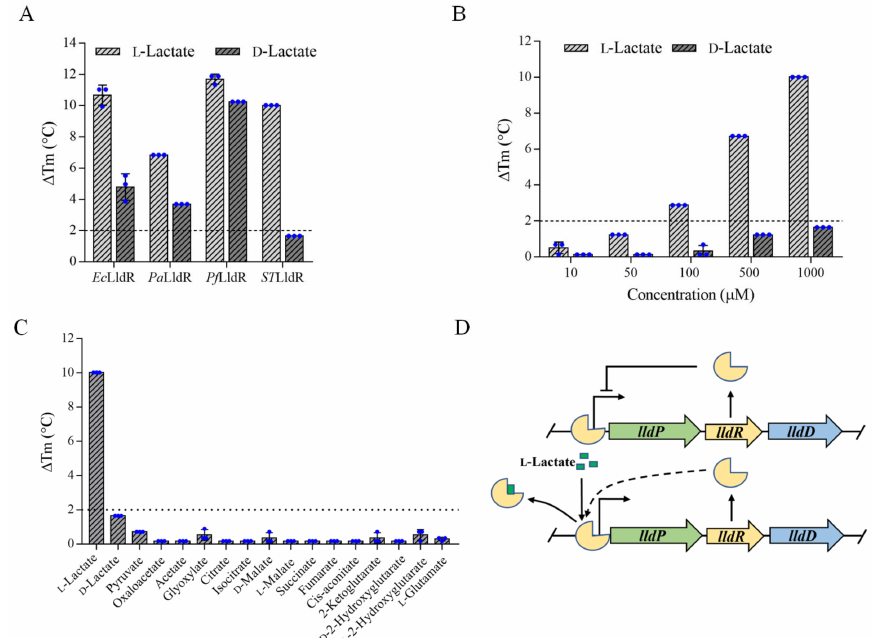
Figure 1. Identification of the L -lactate specific recognition element for biosensor construction. ( A ) Analysis of the interactions of Ec LldR, Pa LldR, Pf LldR, and ST LldR with L -lactate and D -lactate by FTS assays. The ∆ T m values refer to the changes in the T m of different LldRs in absence or presence of 1 mM D -lactate or L -lactate. ( B ) Comparison of the interaction of ST LldR with increasing concen- trations (10, 50, 100, 500, and 1000 µ M) of L -lactate and D -lactate. ( C ) Specificity analysis of ST LldR. The ∆ T m values of ST LldR were measured in the presence of 1 mM L -lactate, D -lactate, pyruvate, ox- aloacetate, acetate, glyoxylate, citrate, isocitrate, D -malate, L -malate, succinate, fumarate, cis-aconitate, 2-ketoglutarate, D -2-hydroxyglutarate, L -2-hydroxyglutarate, L -glutamate. ( D ) Schematic of the regu- latory mechanism of the L -lactate utilization in S. Typhimurium LT2. ST LldR represses the expression of lldPRD genes. L -Lactate serves as the effector of ST LldR and prevents ST LldR binding to the promoter region of lldPRD operon. The direction of gene translation in the lldPRD operon is indicated by the arrow. LldP, lactate permease; LldR, transcription regulator; LldD, L -lactate dehydrogenase. All data shown are mean ± standard deviations. (s.d.) ( n = 3 independent